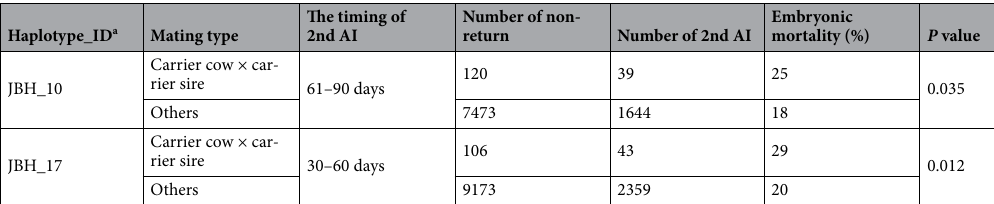
Table 2. Effects of haplotypes on embryonic mortality rate. a Haplotype IDs consist of “JBH” for “Japanese Black haplotype,” followed by chromosome